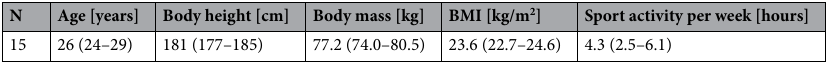
Table 1. Demographic data of the subjects (N = 15). Data are presented as the mean (95%